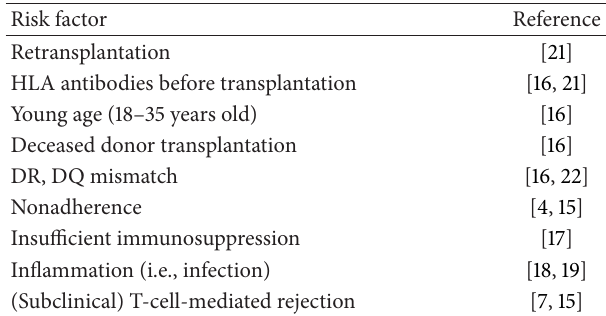
Table 1: Risk factors for the de novo development of